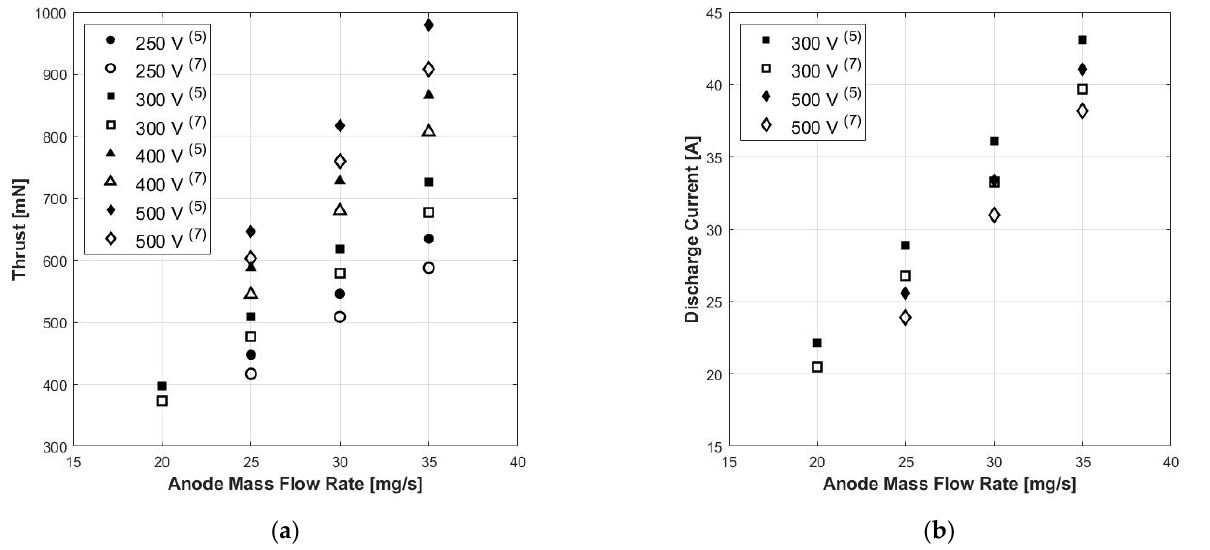
Figure 8. Measured thrust and discharge current for the HT20k M with 5 and 7 cold panels. The thrust levels are shown in ( a ) and the discharge current at 300 and 500 V in ( b ). Bold markers are relative to 5 panel operations, and the total mass flow rate was m tot = m a ( 1 + 0.08 ) . As can be seen, when the chamber was operating with 5 panels, the measured thrust and the discharge current were always larger.